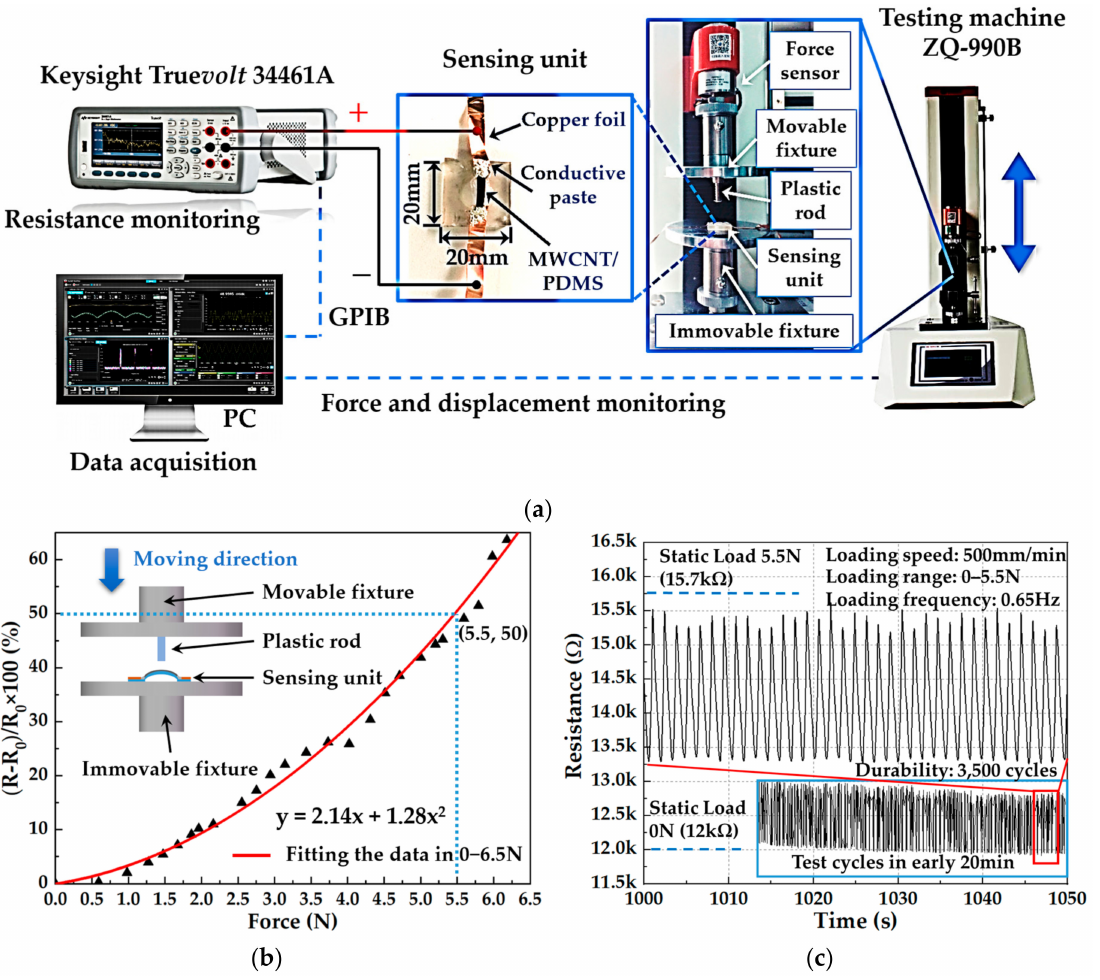
Figure 8. The calibration and stability test of tactile sensor unit: ( a ) The configuration of the testing system; ( b ) The calibration of the tactile sensor unit; ( c ) The stability and reproducibility test of the tactile sensor